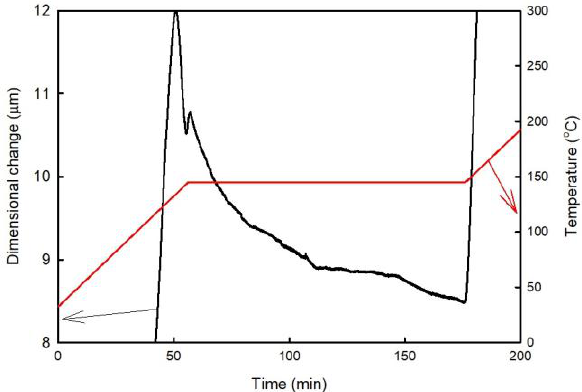
Figure 7. Time dependence of the dimensional changes of the A1 sample (FR4 laminate) observed at 145 °C.